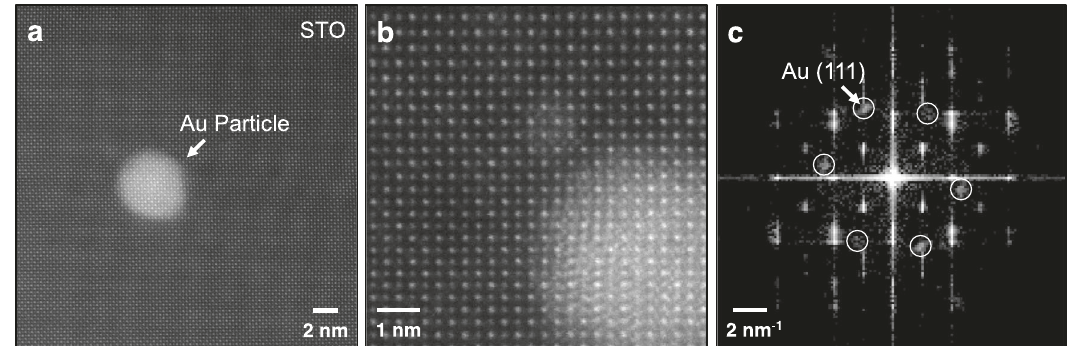
Fig. 1 Atomic-scale structure of a heterogenous catalyst comprising Au nanoparticles on an (001)-oriented STO support, revealed by HAADF-STEM. a Low-magni fi cation image of isolated Au nanoparticle on an STO support. b High-magni fi cation image of the Au nanoparticle and c the corresponding FFT, with spots originating from the Au particle circled, showing the particle ’ s